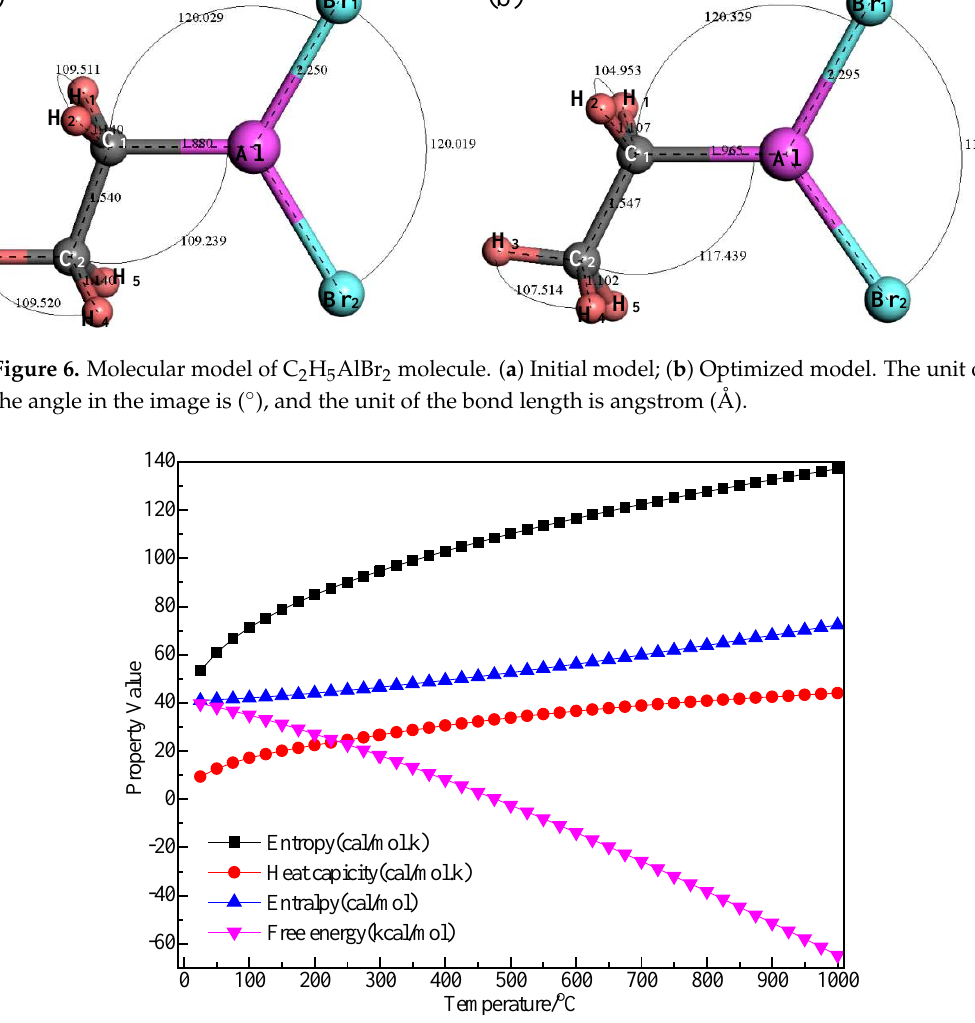
Figure 7. The relationship between the thermodynamic properties of C 2 H 5 AlBr 2 and temperature.